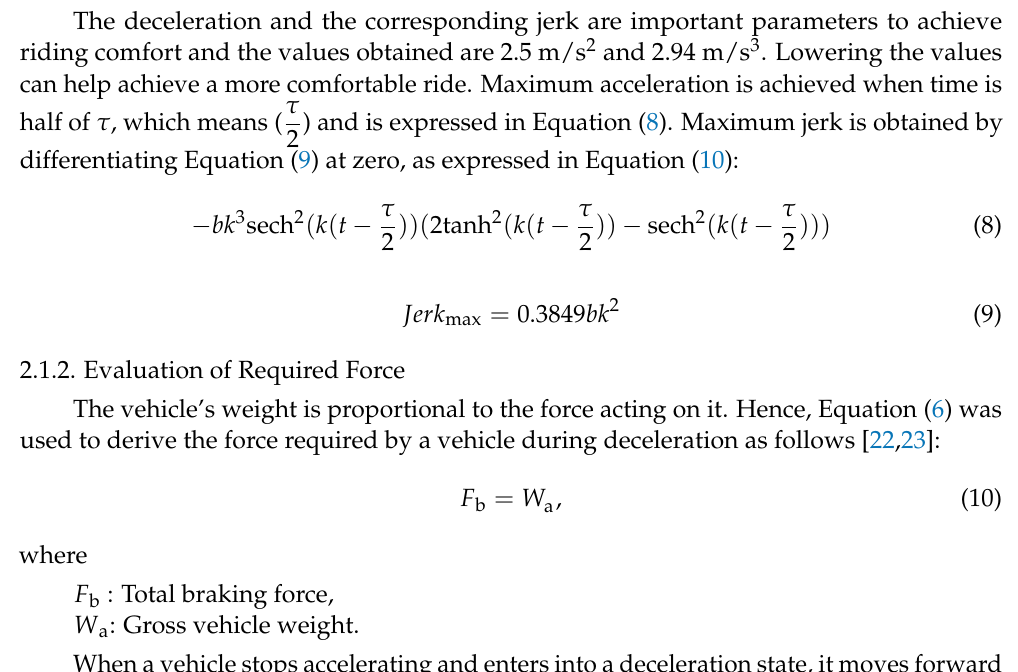
Figure 8. Proposed deceleration model: acceleration and